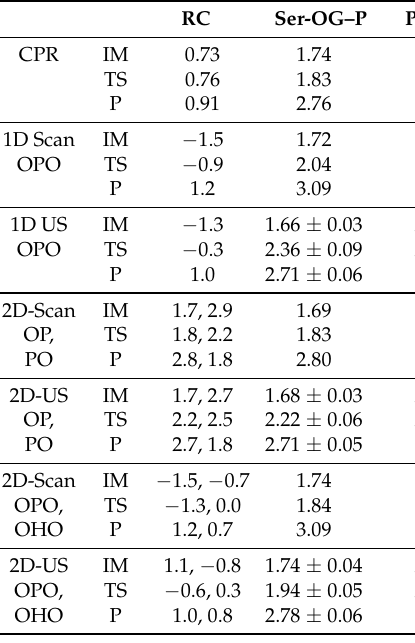
Table 2. Coordinates of end states (IM and P) and transition state (TS) along Step 1 of the phospho- hydrolysis reaction in PSP, computed with conjugate peak refinement (CPR), one- and two-dimensional potential energy scans, and by one- and two-dimensional umbrella sampling (US). Coordinate values from umbrella sampling are averaged over the simulation with the centre of the biasing potential at the reaction coordinate (RC or RC1 and RC2) values of the respective state (IM, TS, or P) on the free energy surface and may therefore differ from these values. OPO refers to the linear combination of P–O distances, [d(Ser-OG–P) − d(P–O-Asp11)], OHO to the linear combination of O–H